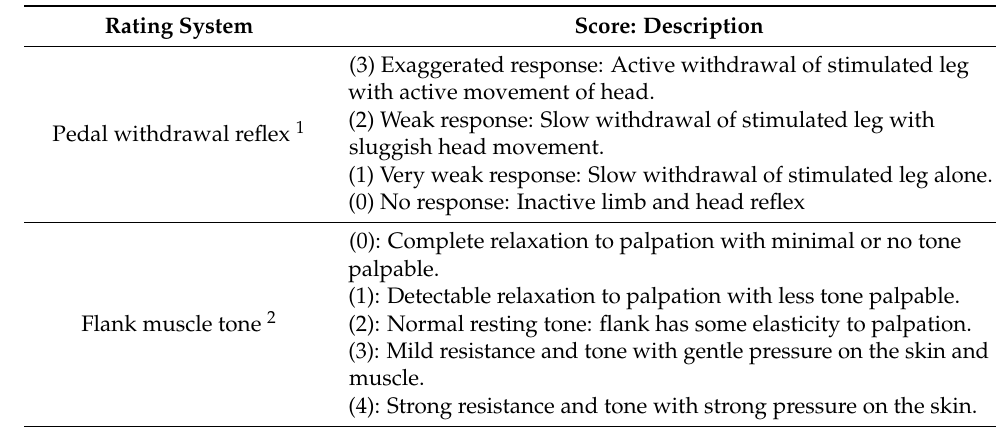
Table A2. Pedal withdrawal response and flank muscle tone rating